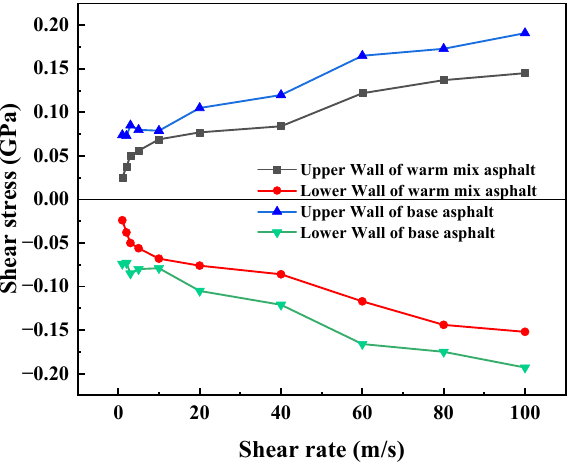
Figure 10. Effects of the IMDL WMA additive on the stress of the